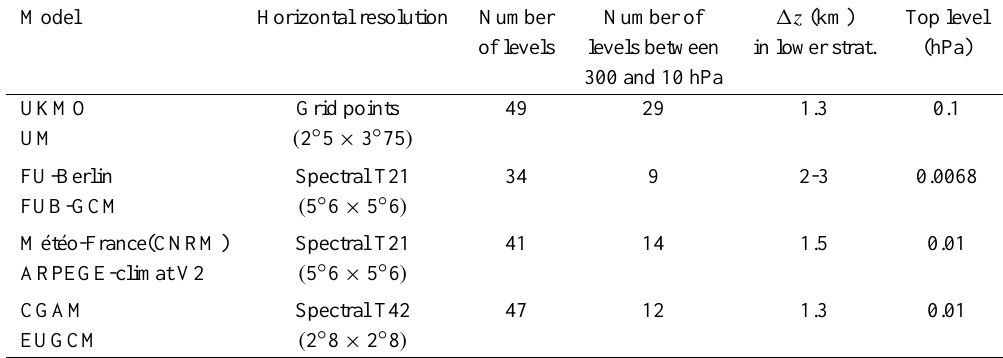
Table 2. Summary of the horizontal and vertical resolutions of the models Model Horizontal resolution Number of levels levels